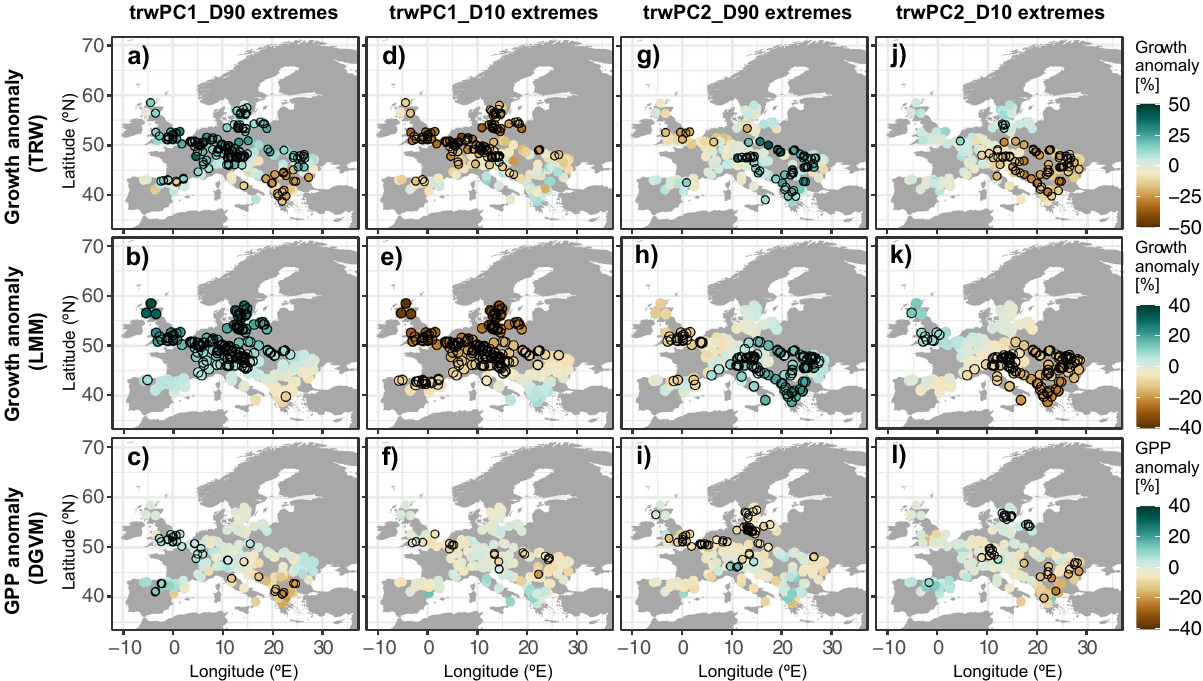
Fig. 4 European beech radial growth and forest productivity during TRW extremes. Anomalies in radial tree growth (TRW, a , d , g , j ), simulated anomalies in radial tree growth by the LMM ( b , e , h , k ), and DGVM ’ s simulated anomalies in forest GPP ( c , f , i , l ) for the years showing the largest radial tree growth anomalies (i.e., D10 and D90 of trwPC1 and trwPC2 scores, see Supplementary Table 1, Fig. 3). Anomalies are expressed as percentages from the mean for the period 1950 – 2005. Black circles indicate signi fi cant anomalies ( p <